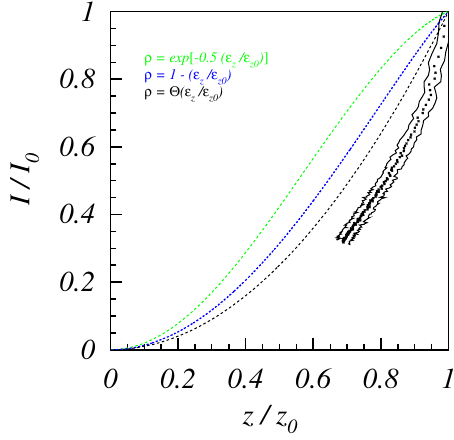
FIG. 19. High intensity bunched beam: beam loss/bunch length correlation. The two continuous thin lines represent the error bar. The dashed curves represent the theoretical correlation for several longitudinal particle distributions: Gaussian (green), Waterbag (blue), and KV (black).